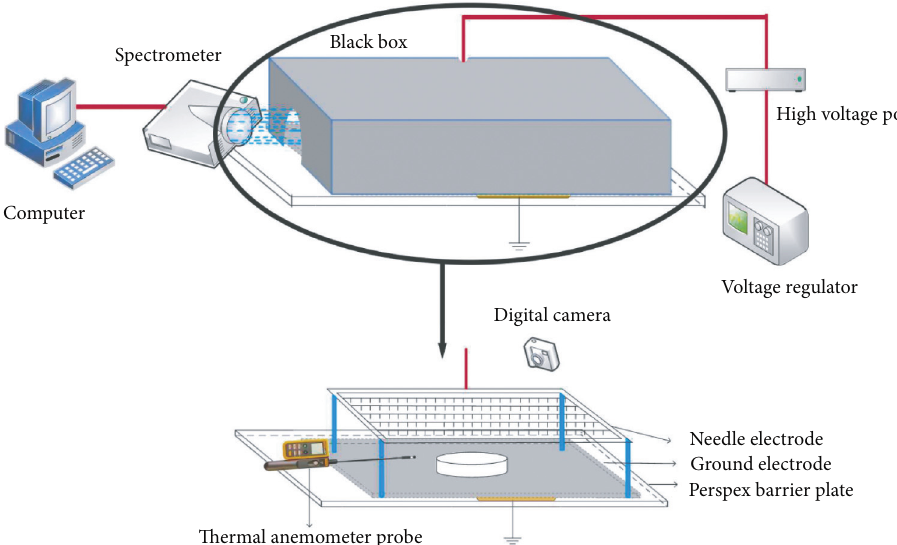
Figure 1: Experimental device